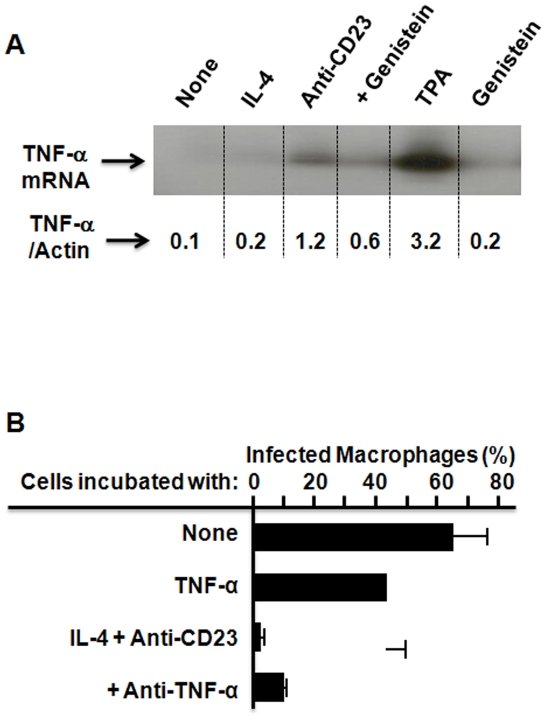
Minor role for CD23-induced TNF-α during activation of parasiticidal activity of human macrophages.(A) CD23 engagement induces TNF-α gene expression in human macrophages through tyrosine kinase-sensitive pathway. Data from one donor was shown, out of two. (B) Recombinant TNF-α (100 IU/ml) induced low but significant elimination (p<0.007) of parasites in infected cells while anti-TNF-α McAb (20 µg/ml) had limited effect on CD23-mediated parasiticidal activity of human macrophages. Results show mean±SD from three distinct MDM preparations following 72 h incubation, each done in duplicates.